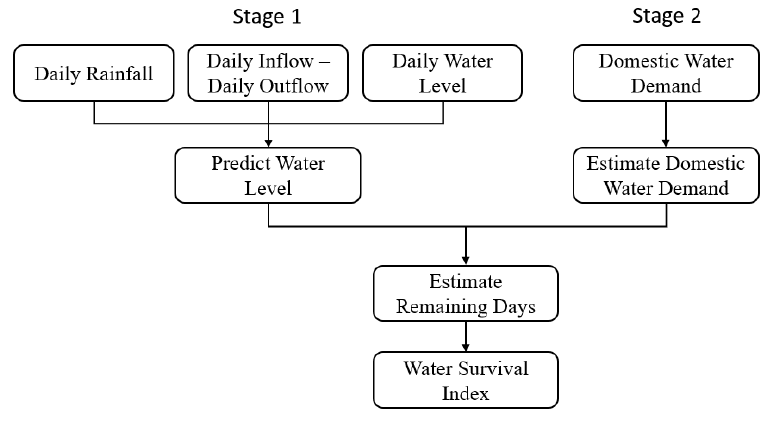
Figure 2. Proposed approach.